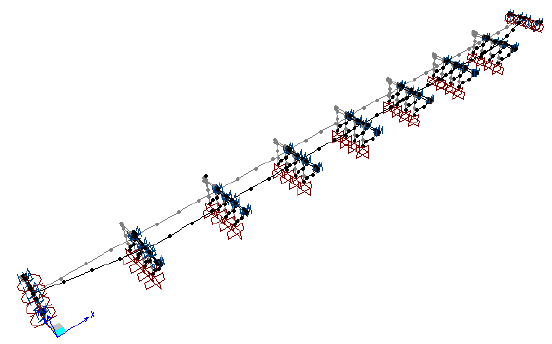
Fig. 7. Mode shape in the transverse direction (Mode 1) Fig. 8. Mode shape in the longitudinal direction (Mode